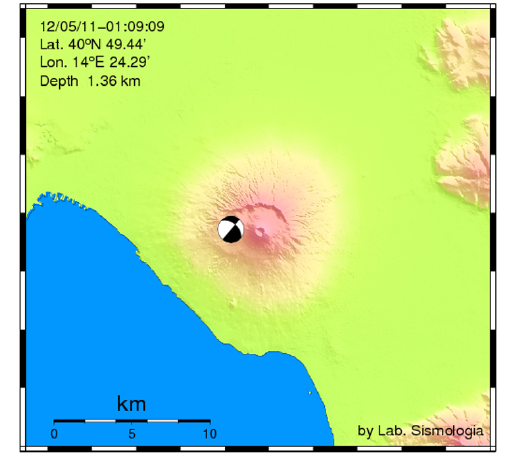
Figure 11. Focal mechanism and epicenter location of the low-fre- quency event.